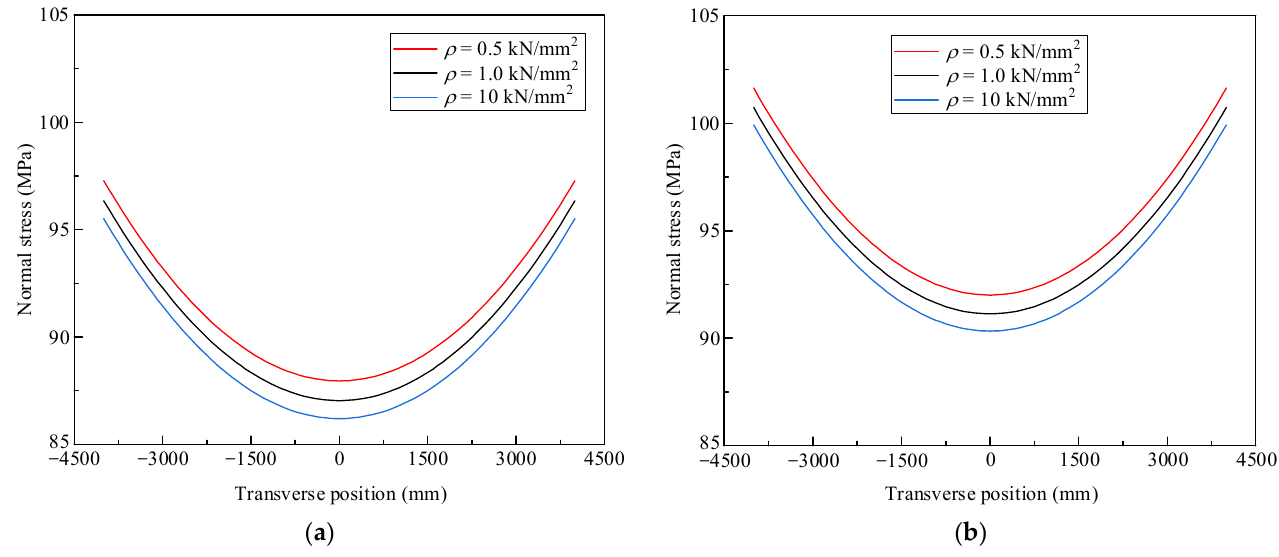
Figure 12. Stresses at the bottom flange of the steel beam (influence of shear connection stiffness). ( a ) 28 days; ( b ) 3 years.